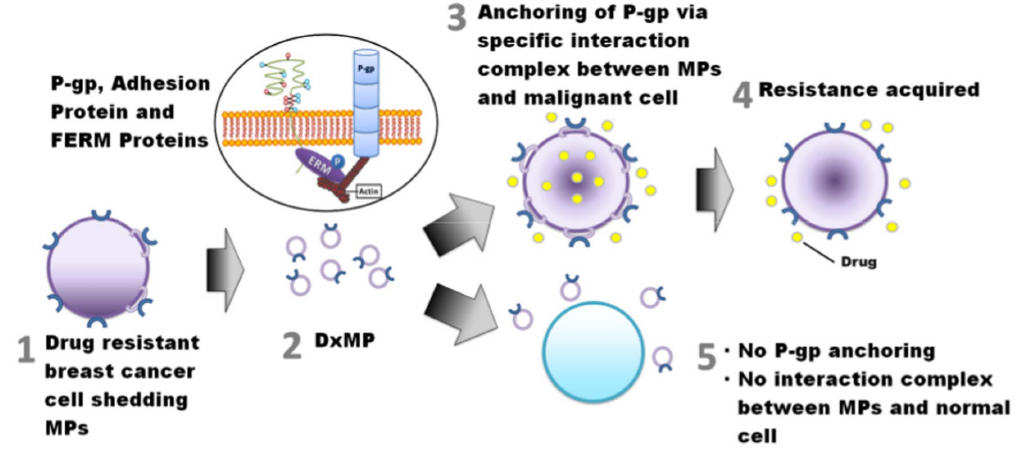
Figure 6. Hypothesis Overview. An interaction complex involving discrete MP surface molecules and FERM domain proteins (including Ezrin) serve to selectively target and anchor P-gp to breast cancer cells upon MP binding. This leads to the selectivity in dissemination and acquisition of MDR trait in cells.